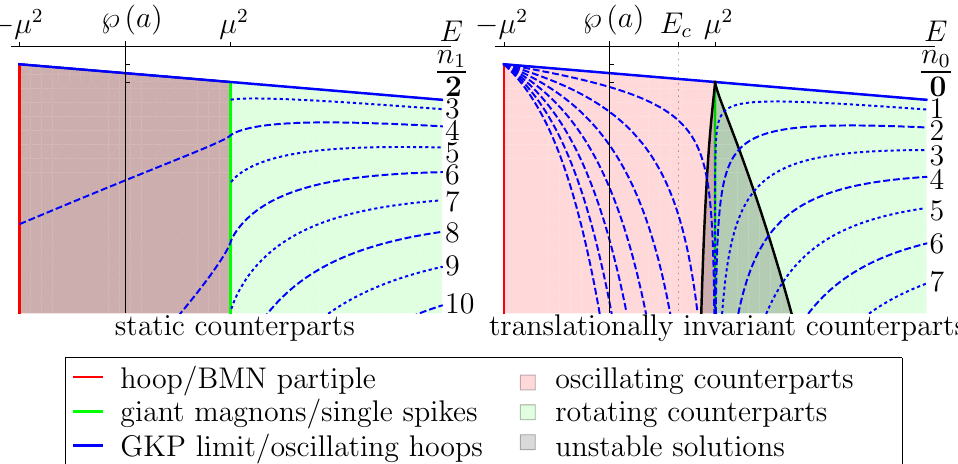
Figure 2 . The set of unstable elliptic string solutions in the moduli space. The dashed and dotted blue lines depict the closed elliptic strings. They are indexed by the number of the real periods of the Weierstrass elliptic function that covers